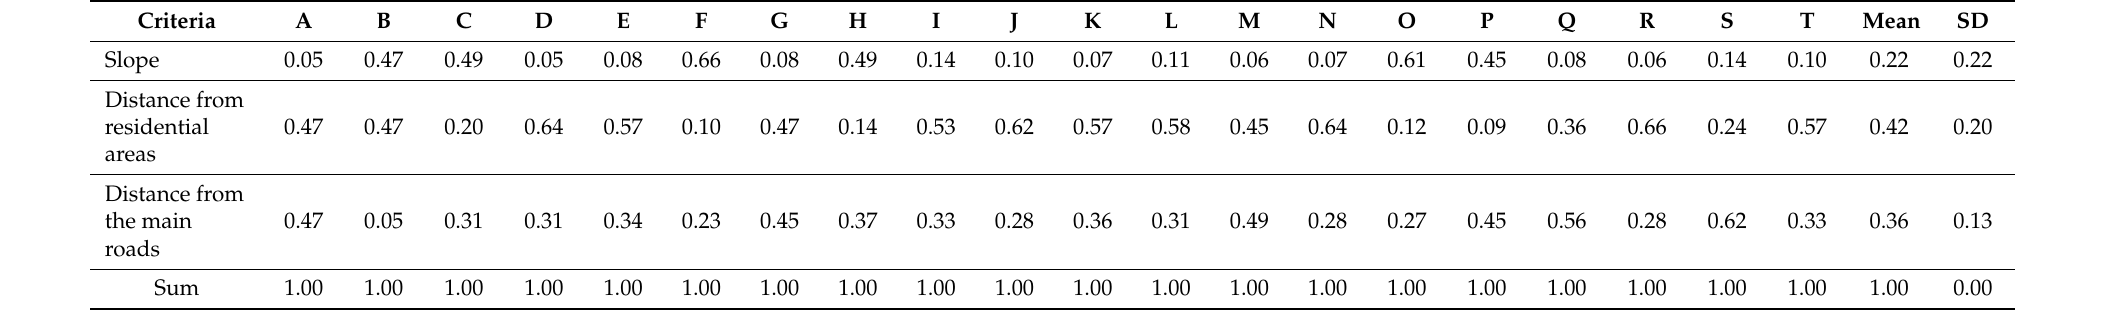
Table 5. Weights of the criteria for industrial areas suitability mapping using